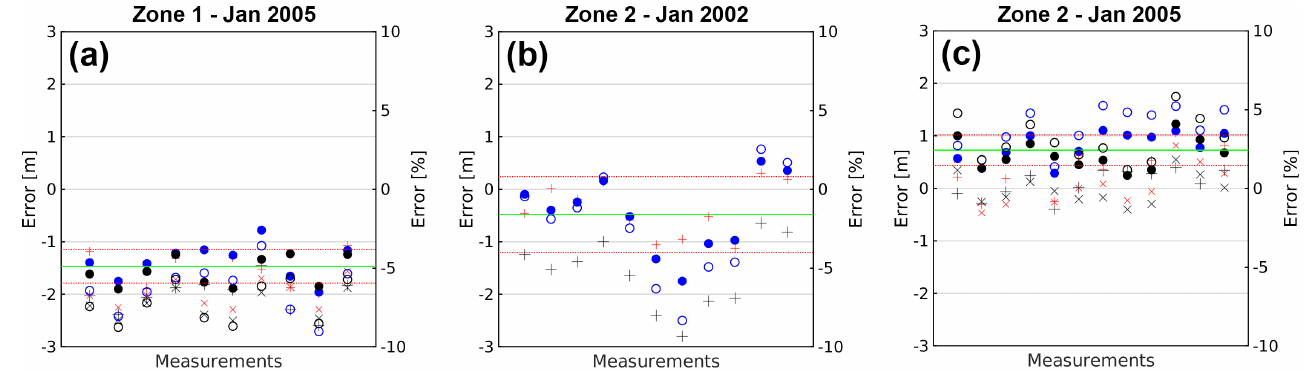
Figure 18. Errors of the shadow-derived freeboard heights measured at the Abbot ice shelf. Errors were estimated as the difference between shadow-derived measurements and reference values obtained from ICESat laser altimetry. Circles represent measurements done with the presented methodology, solid circles corresponds to the error in meters (left axis) and empty circles to the relative error (right axis). Blue and black circles represent nadir- and backward-looking bands respectively. The solid green line shows the mean value of errors, and the red dotted line shows the standard deviation of errors around the mean. Thin markers (“+” and “ × ” symbols) represent solutions neglecting atmospheric refraction (black) or fine shadow adjustment (red), in this case nadir- and backward-looking bands are represented by “+” and “ × ” symbols respectively. ( a ) Errors for 20 measurements carried out in Zone 1 on the ASTER image from 4 January 2005; ( b ) Errors for 11 measurements carried out in Zone 2 on the ASTER image from 14 January 2002; and ( c ) Errors for 24 measurements carried out in Zone 2 on the ASTER image from 4 January 2005. Zone locations are shown in Figure